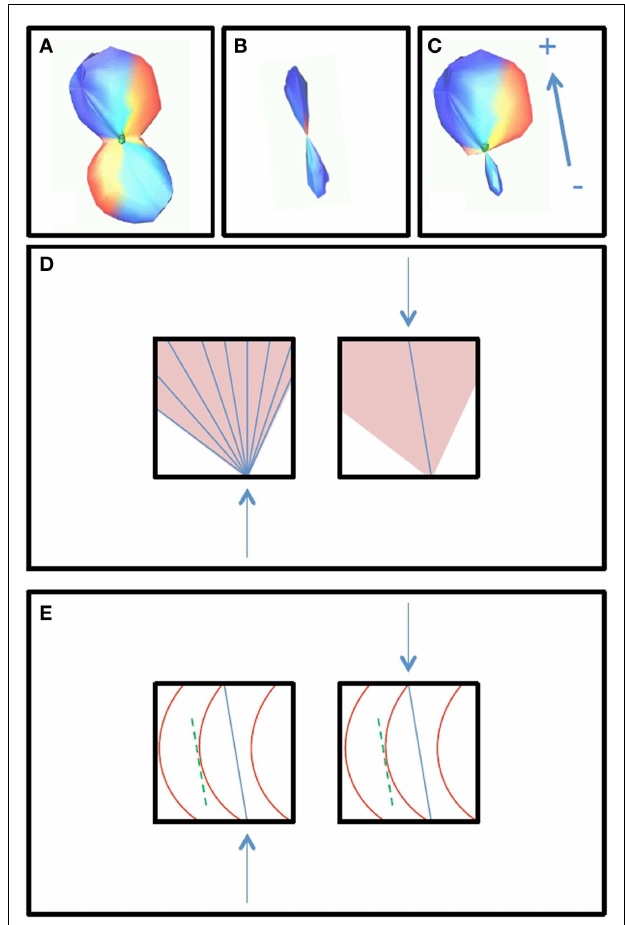
FIGURE 1 |The construction of the PDF for the direction of tractography is shown . Broad fiber ODFs, shown in box (A) , may be due to either fanning or curvature, and curve inference distinguishes between these cases. In the case of fanning, fanning of the streamlines propagated in tractography will occur in only one direction [ + , as indicated by the polarity vector in box (C) ], while in the other direction, there is a merge [ − in box (C) ]. In the merge direction, and in the case of curvature, tractography follows non-zero directions in the PDF for the fiber ODF maximum [box (B) ].The PDF for the direction of propagation for curvature is then equal to the PDF for the fiber ODF maximum (B) , and the PDF for the direction of propagation for fanning/merging (C) is the combination of the average fiber ODF (A) and the PDF for its maximum (B) . Box (D) illustrates how the streamlines will propagate using FACT integration in the cases of fanning (left) and merging (right). Box (E) illustrates how the streamlines will propagate in the case of curvature.The fiber ODF maximum is assumed to represent the intermediate tangent to the curve, which is used as a discretized approximation to the curve segment in the voxel, entering and exiting the voxel where the curve would have